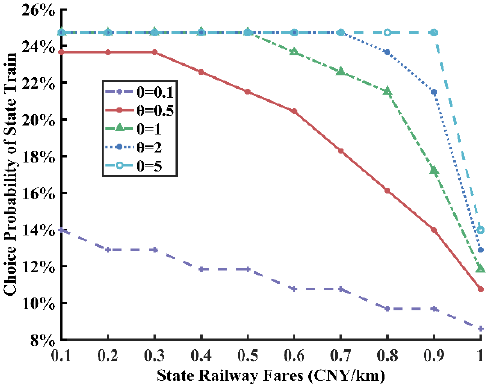
Figure 14. Sensitivity analysis of state railway fares to state train choice probability of suburban passengers at station No. 8 (Current train No. 8: State).